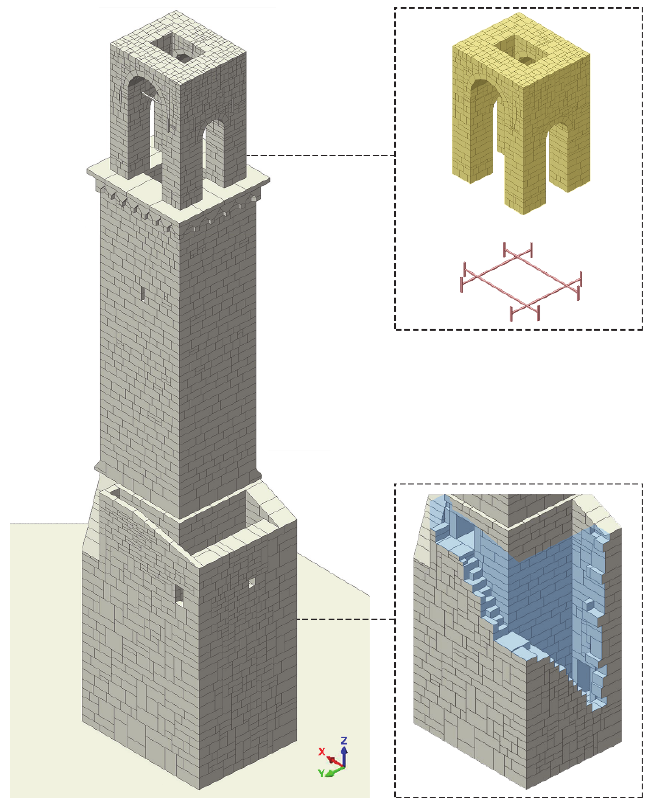
Figure 11: Views of the particular components of the numerical models of the civic clock tower of Amatrice (Rieti, Italy) with the NSCD